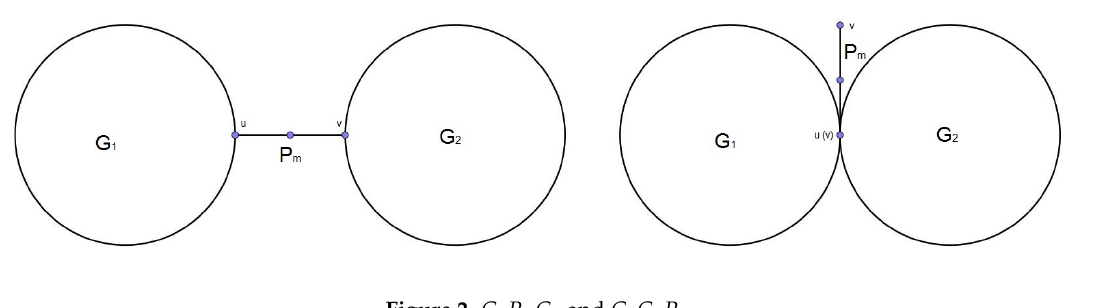
Figure 2. G 1 P m G 2 and G 1 G 2 P m .